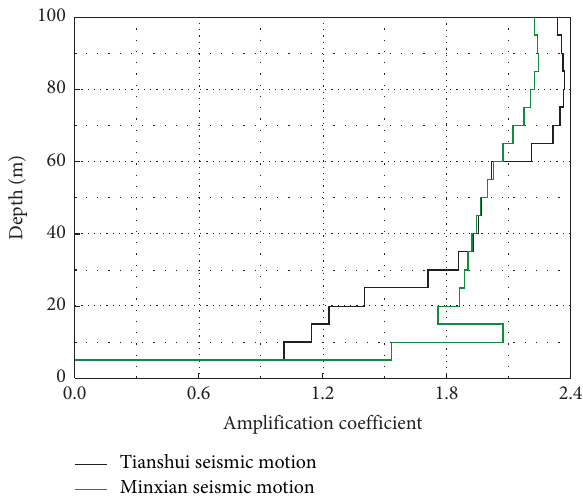
Figure 7: The distribution of the PGA amplification coefficients.